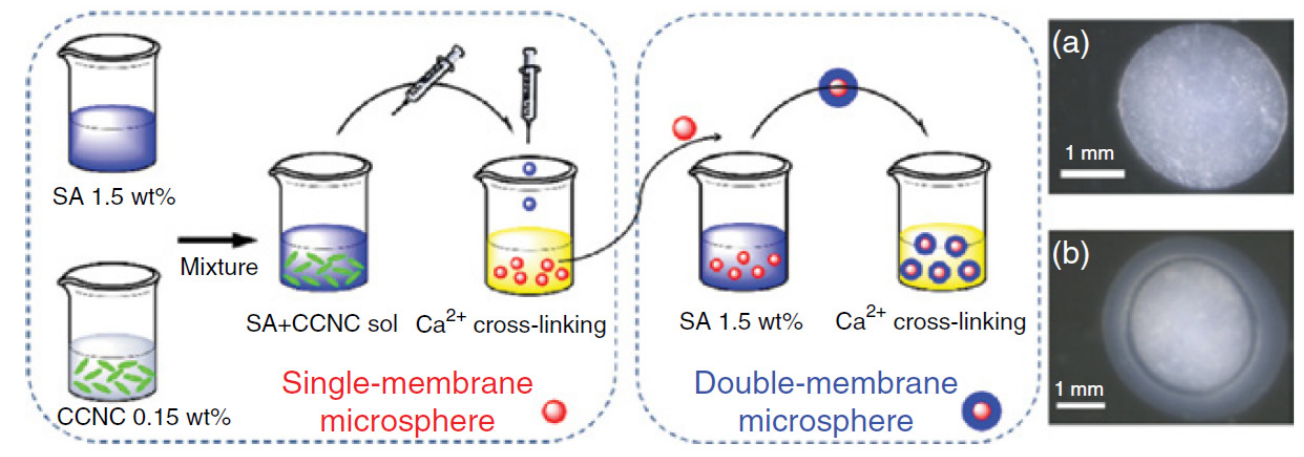
Figure 2. The preparation routine of single-membrane and double-membrane microsphere hydrogels. Optical microscope images of ( a ) the SA/CCNC single-membrane microsphere hydrogel and ( b ) the SA/CCNC-1 h double-membrane microsphere hydrogel. Reprinted with permission from the authors of [89]. Copyright 2016 American Chemical Society.